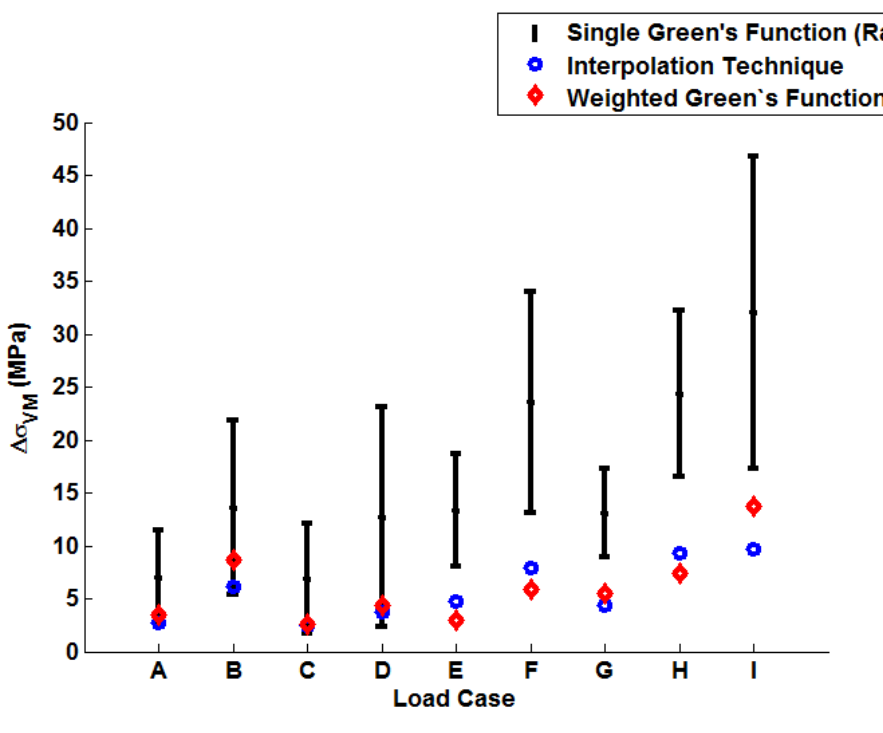
Figure 15. A plot to show the relative performance of the various implementation methods (using ∆ σ VM